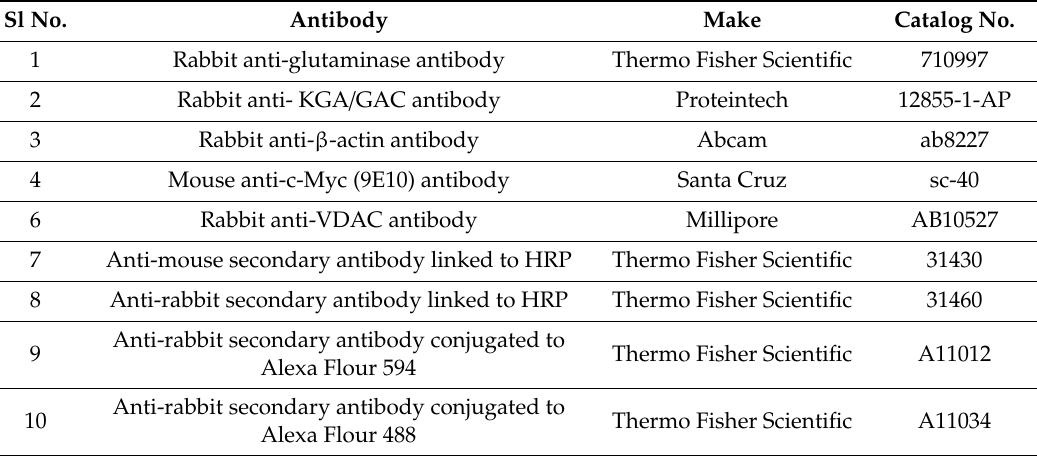
Table 1. List of